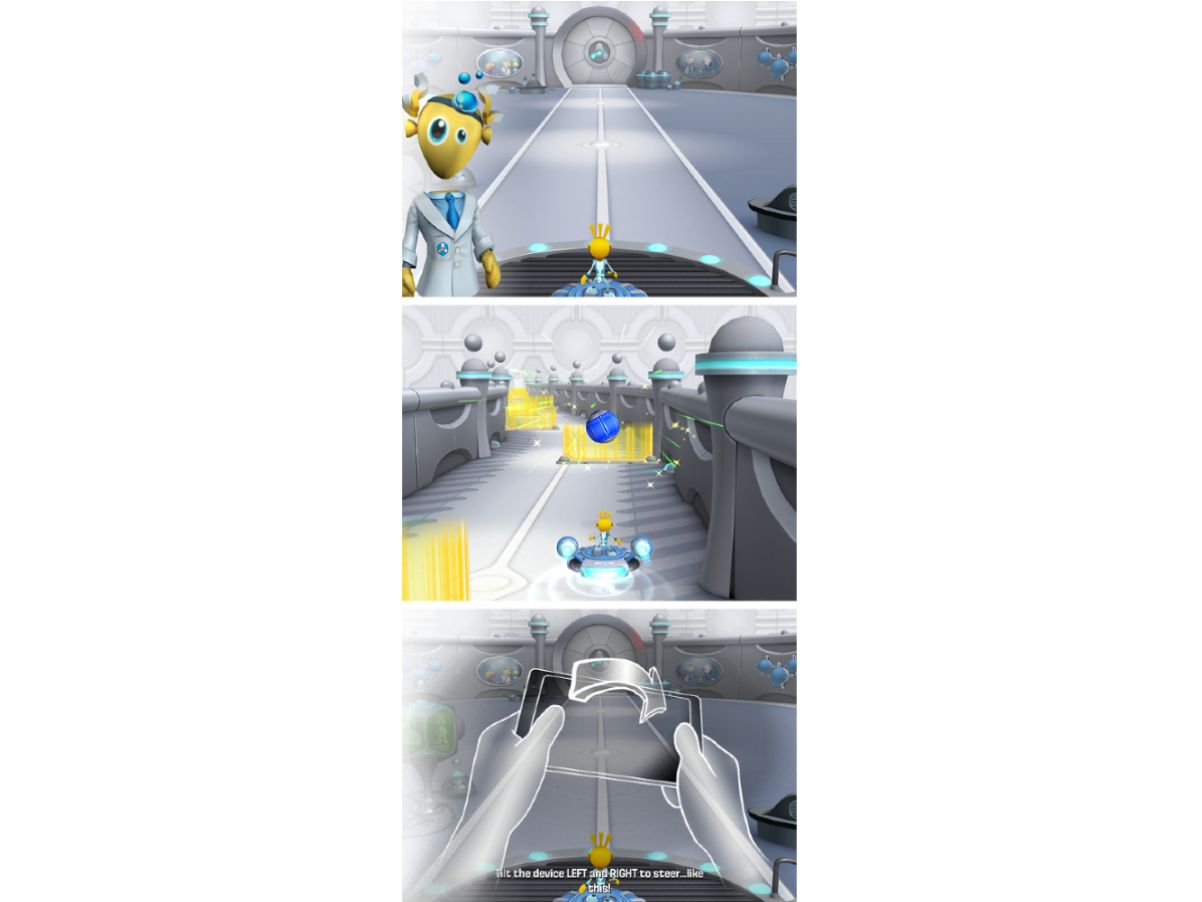
Figure 1. Screenshot of the EVO Monitor cognitive assessment program. The participants are instructed to respond to colored target stimuli by tapping the iPad screen while navigating a character along a dynamically moving road and avoiding walls and obstacles by tilting the iPad. Copyright © 2020-2021, Akili Interactive Labs, Inc. All rights